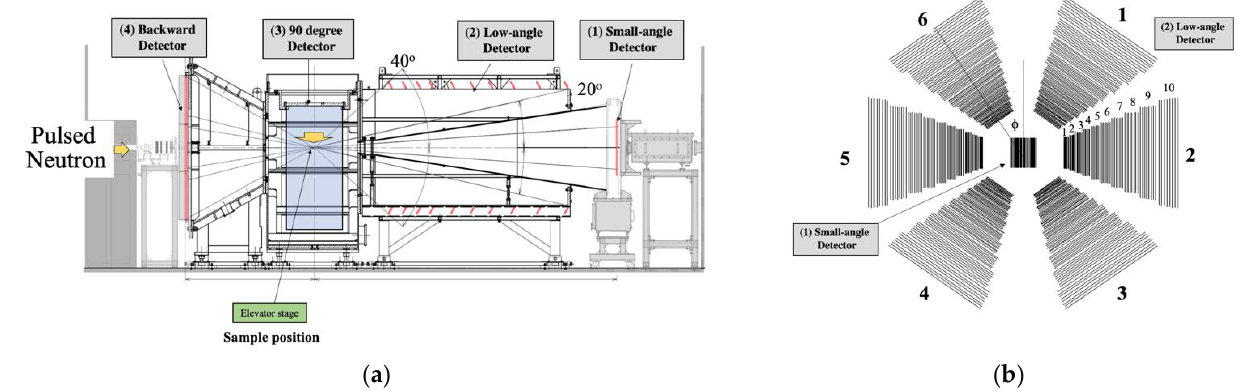
Figure 2. iMATERIA spectrometer at J-PARC, with neutrons entering from the right to the detectors on the left. ( a ) side view showing 4 detector blocks surround a sample position; ( b ) small-angle and low-angle detectors viewed from sample position.